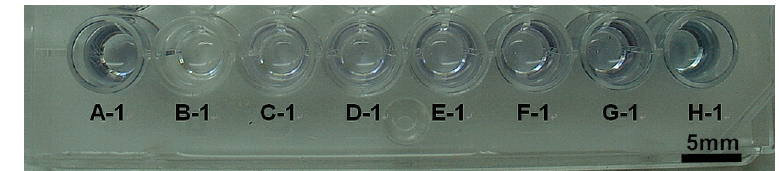
Figure 10. Photograph of results of ELISA assays.